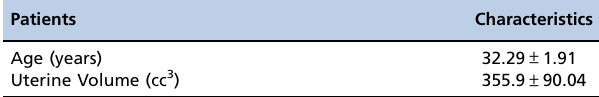
Table 1 - Demographic data of the patients analyzed